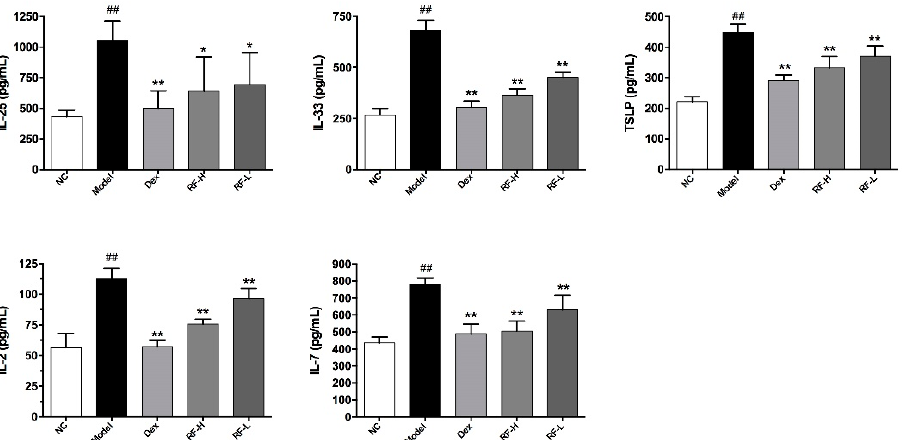
Figure 6. The effects of Renifolin F on IL-25, IL-33, TSLP, IL-2 and IL-7 levels in BALF. Normal control,